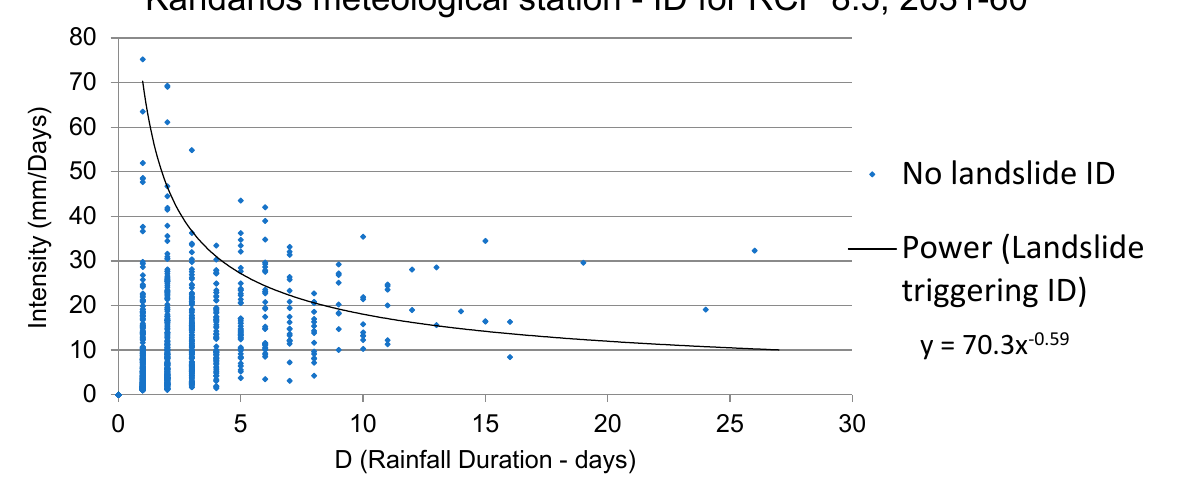
Figure 13. ID diagram according to the RCP8.5 emission scenario for 2031–2060 at the Kandanos meteorological station.